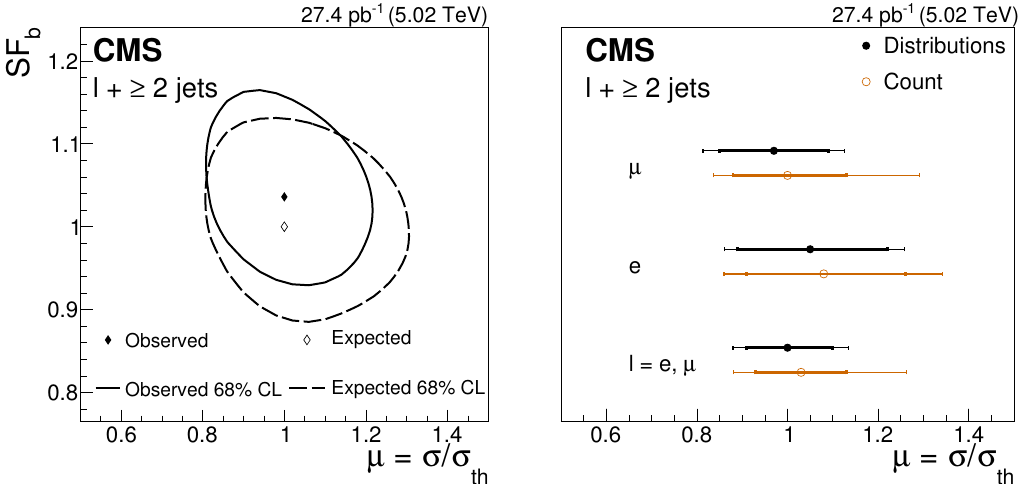
Figure 2 . Left: the 68% CL contour obtained from the scan of the likelihood in ‘ +jets analysis, as a function of (cid:22) and SF b in the ‘ +jets analysis. The solid (dashed) contour refers to the result from data (expectation from simulation). The solid (hollow) diamond represents the observed (cid:12)t result (SM expectation). Right: summary of the signal strengths separately obtained in the e+jets and (cid:22) +jets channels, and after their combination in the ‘ +jets channel. The results of the analysis from the distributions are compared to those from the cross-check analysis with event counting